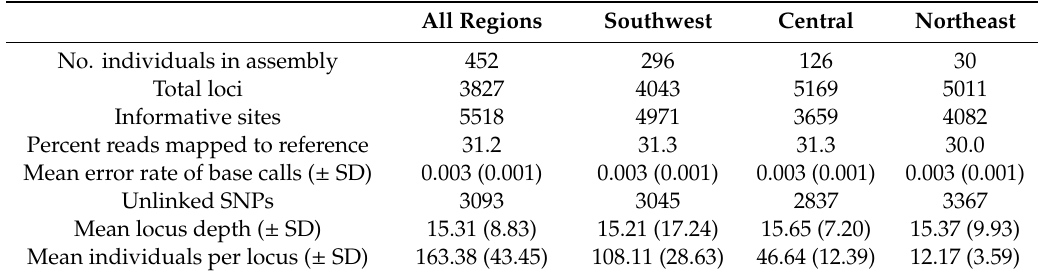
Table 2. Summary statistics for Sclerolaena napiformis assemblies generated using ipyrad. Statistics reported for “unlinked SNPs” and “mean locus depth” were obtained after filtering variant call format (VCF) files with VCFtools. SNP: single nucleotide